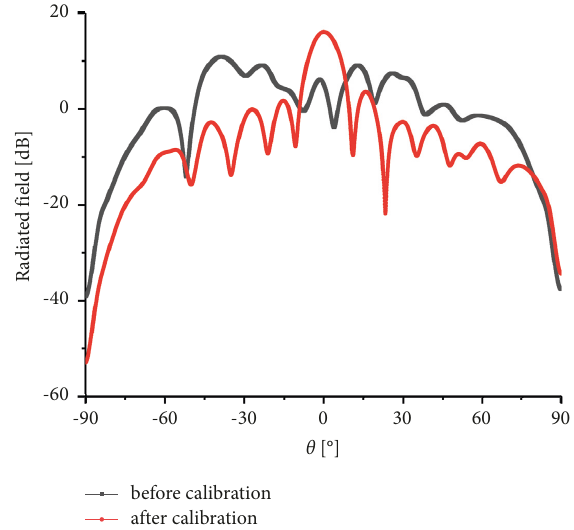
Figure 15: The radiation patterns of the 11 elements before and after